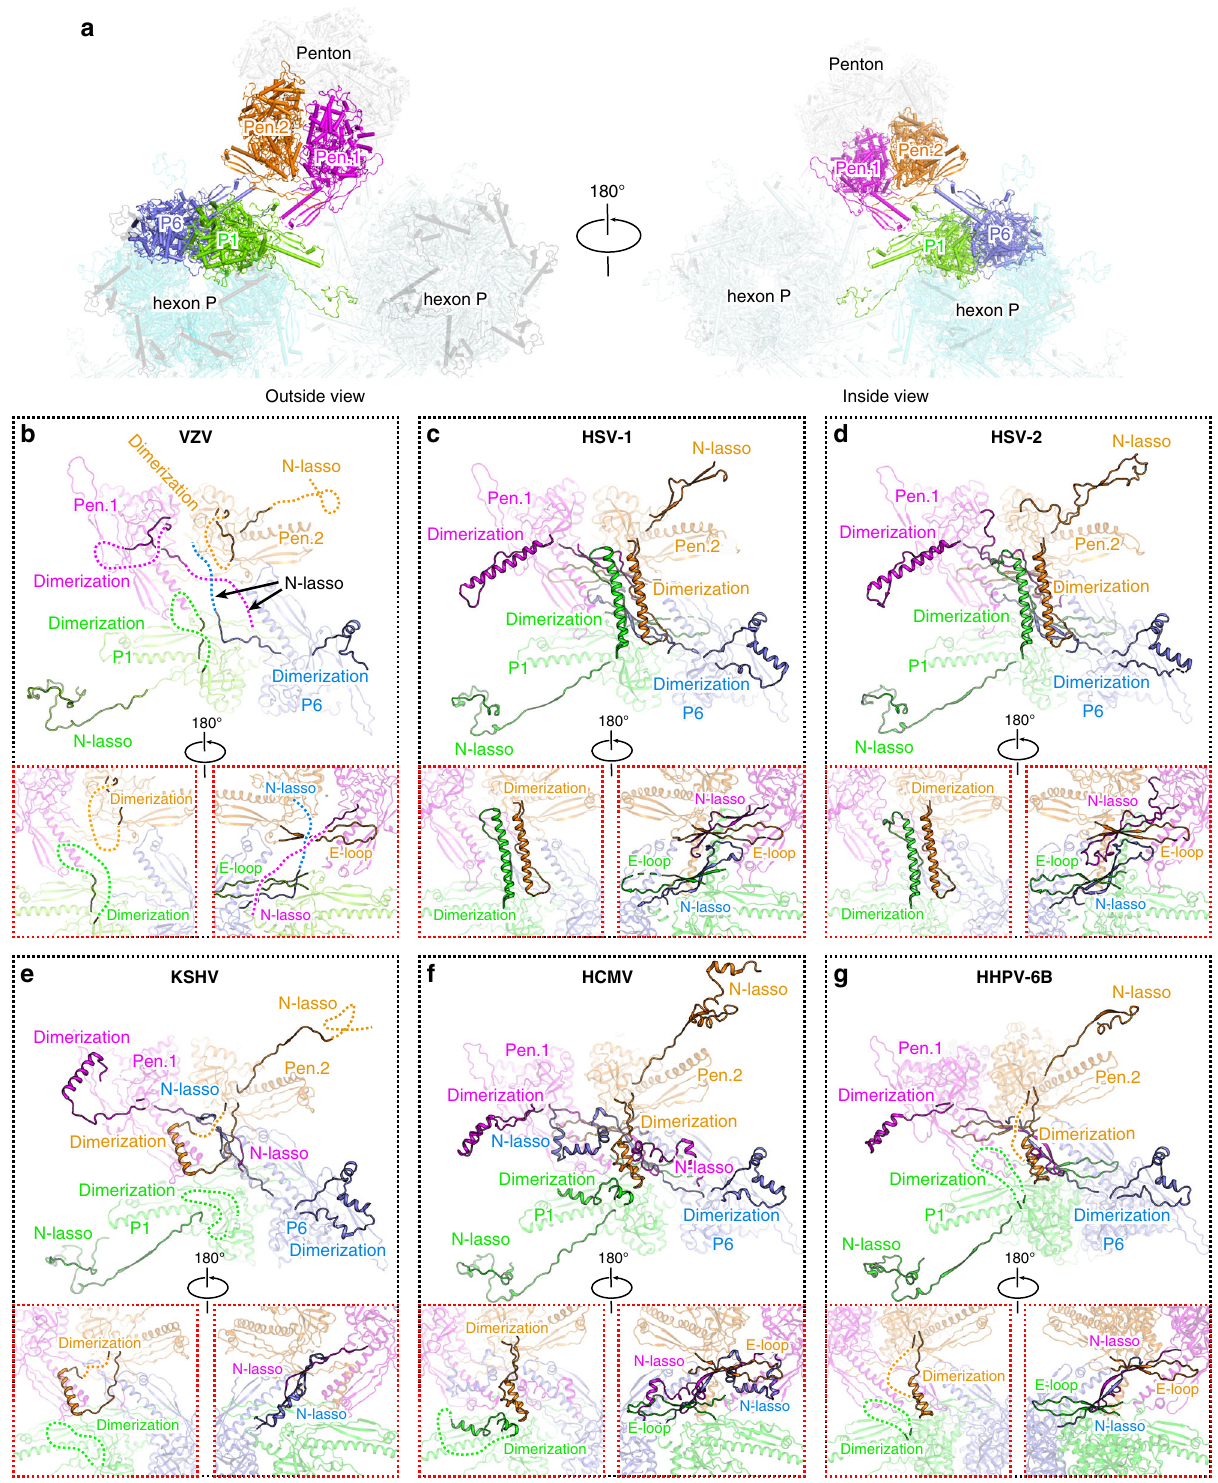
Fig. 4 Comparison of the interaction networks between penton and hexon capsomers in different herpesviruses. a Overview of the contacting interface between penton and hexon capsomers as viewed from outside or inside of the capsid. The four MCP conformers involved in interactions are highlighted in different colors. b – g Close-up views of the interactions between penton and hexon MCPs. The motifs involved in contacts are shown in solid colors, and the rest parts of the subunits are set transparent for clarity. The unresolved regions in the structure are represented by dashed lines. The insets show the zoomed-in inside (left panel) and outside (right panel) views of the central interaction